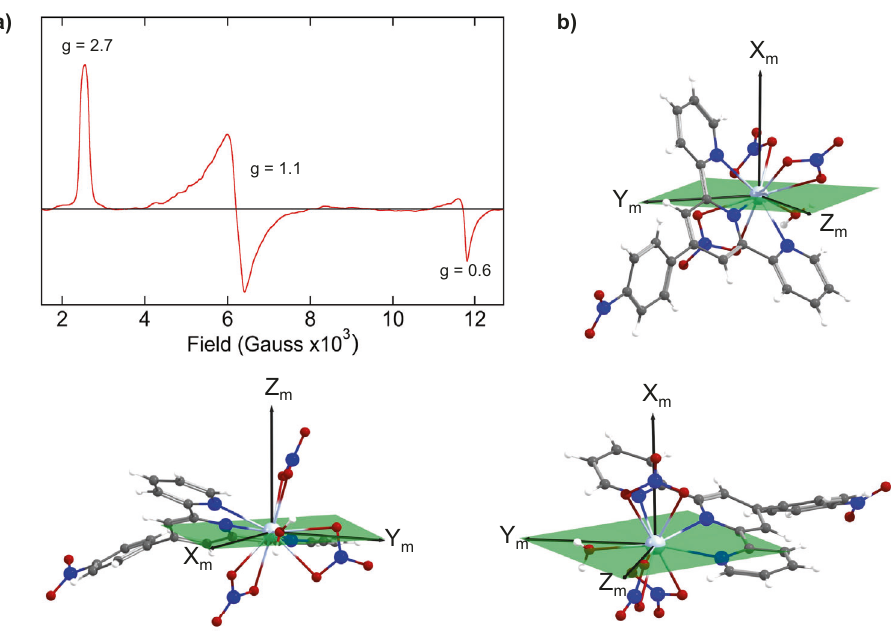
Fig. 3 Electron paramagnetic resonance and g -factors for Ce1. a Experimental EPR spectrum and the corresponding g -factors. b Quantization axes and magnetization planes for the three KDs ordered by increasing energy from left to right. Table 2 g -factors for